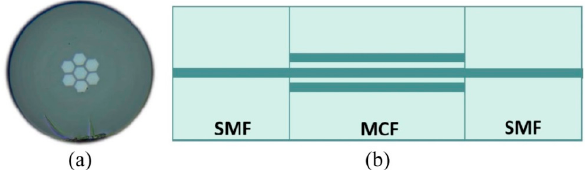
Figure 16. ( a ) Microscope image of a 7-core optical sensing fiber; ( b ) Schematic diagram of MCF-based sensing device structure [138].